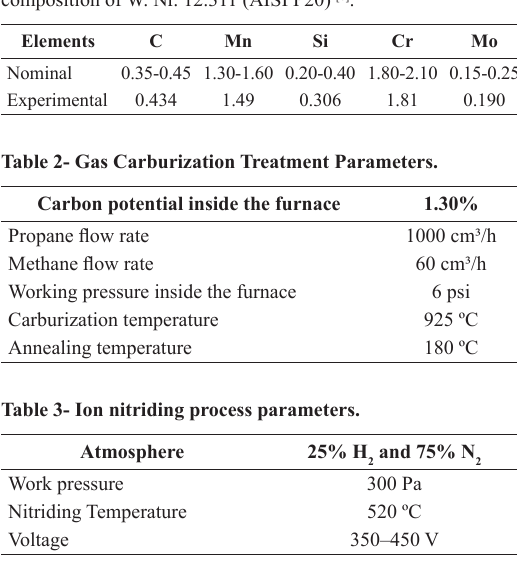
Table 4- Ion nitriding treatment parameters for 12-hour